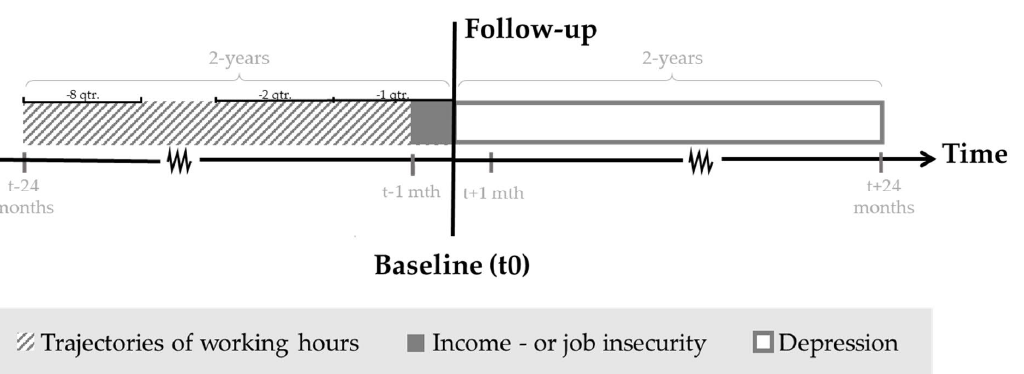
Figure 2. Illustration of the study design. For each participant, the baseline (t0) was set to the DLFS response date. Group-based trajectory modelling was applied on previous working hours evaluated by quarterly average working hours in the two years leading up to baseline (from -8 qtr. to -1 qtr.). Job and income insecurity were assessed at baseline and referred to the past four weeks. Depression was assessed during a two-year follow-up after the